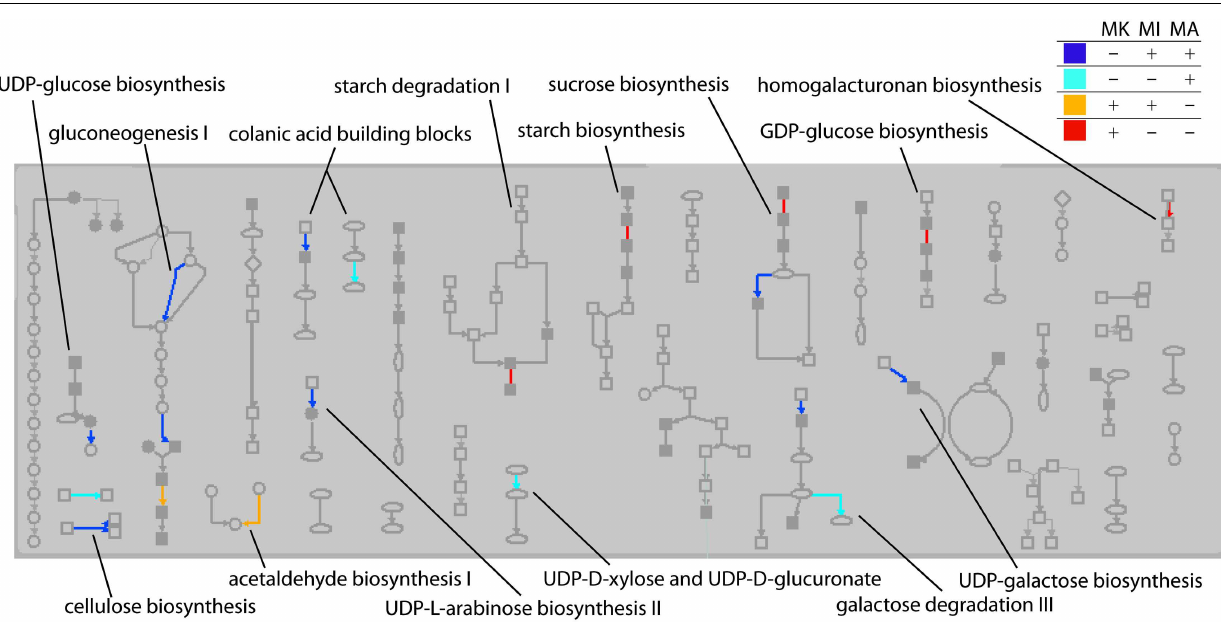
FIGURE 9 | Carbohydrate biosynthesis pathway class showing reactions affected by Mu killer (MK) On/Off transcripts compared to Mu inactive (MI) and Mu Active (MA). Reactions in a pathway that were affected only by